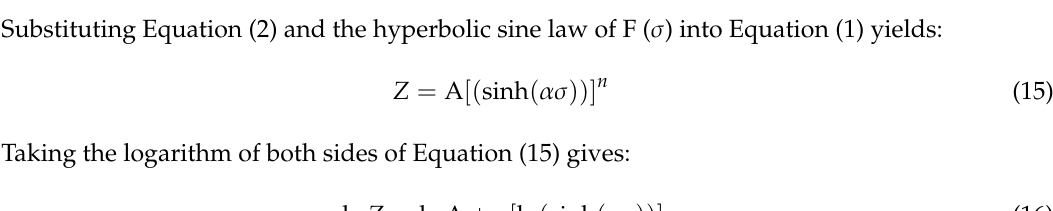
Figure 5. Relationships between ( a ) 1000/T and In[sinh( ασ )]; ( b ) In[sinh( αα )] and lnZ.